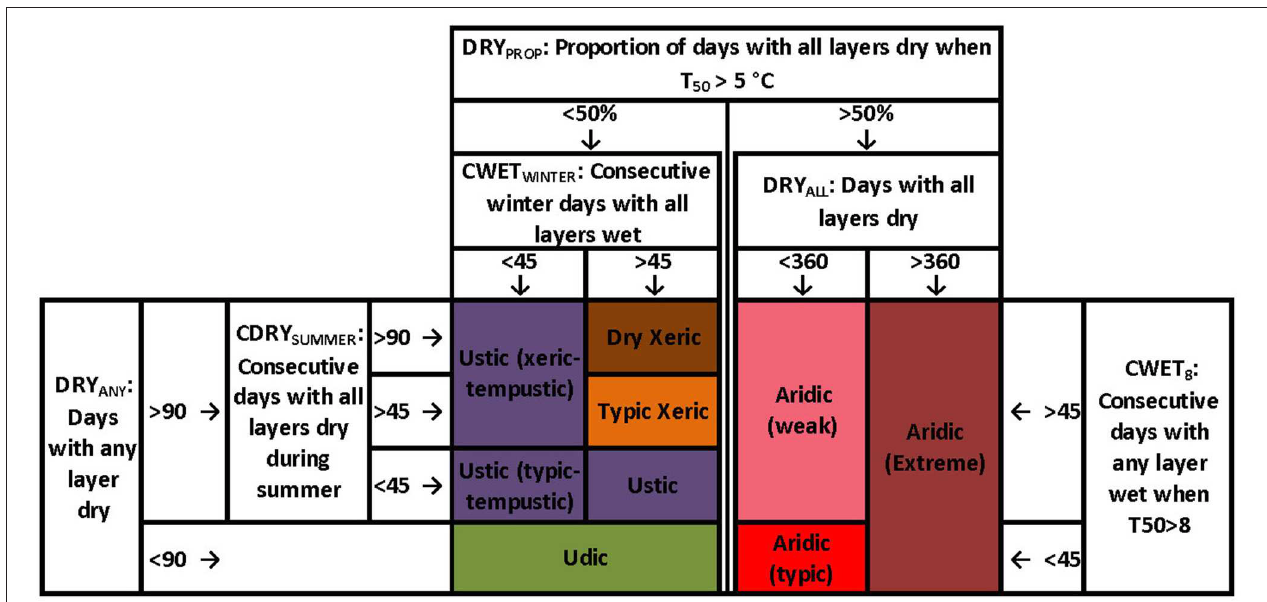
FIGURE 2 | Simplified relationships among soil moisture regimes (colors) and primary criteria for distinguishing the regimes. See text for descriptions of